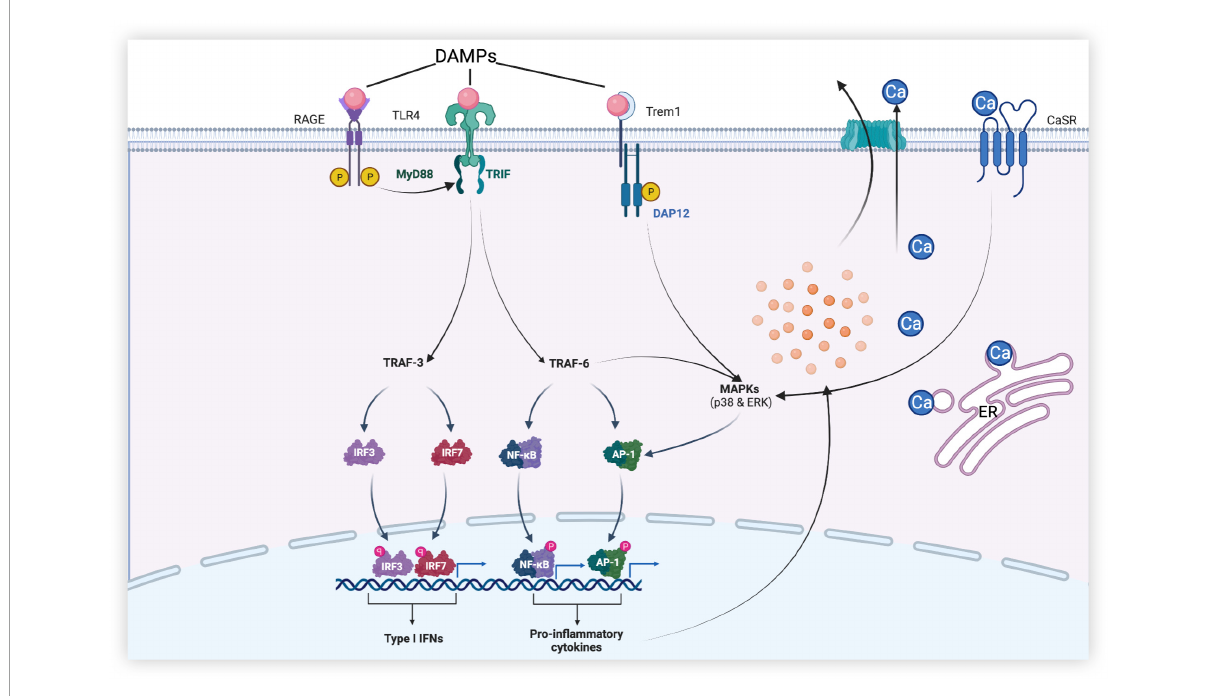
FIGURE3 Dural roles of microglia-associated receptors in early brain injury (EBI) after subarachnoid hemorrhage. [After subarachnoid hemorrhage (SAH), danger-associated molecular patterns (DAMPs) activate receptors such as Toll-like receptor 4 (TLR4), receptors for advanced glycation end (RAGE), and triggering receptor expressed on myeloid cells-1 (TREM-1) of microglia. TLR4 produces a series of pro-inflammatory mediators through MyD88-dependent and Toll receptor-associated activator of interferon (TRIF)-dependent pathways, leading to neuronal apoptosis, disruption of the blood–brain barrier (BBB), and brain edema, etc., while promoting the release of type I IFN to play anti-inflammatory and anti-apoptotic roles. In addition, calcium-sensing receptor (CaSR) and TREM-1 promote mitogen-activated protein kinase (MAPK) expression and initiate downstream inflammatory pathways, thereby aggravating brain